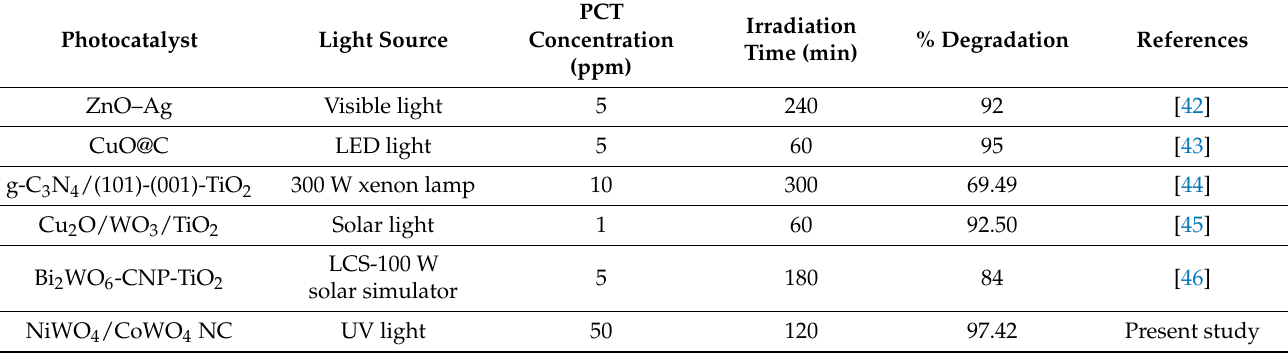
Table 3. Comparison of present study with literature regarding PCT degradation.